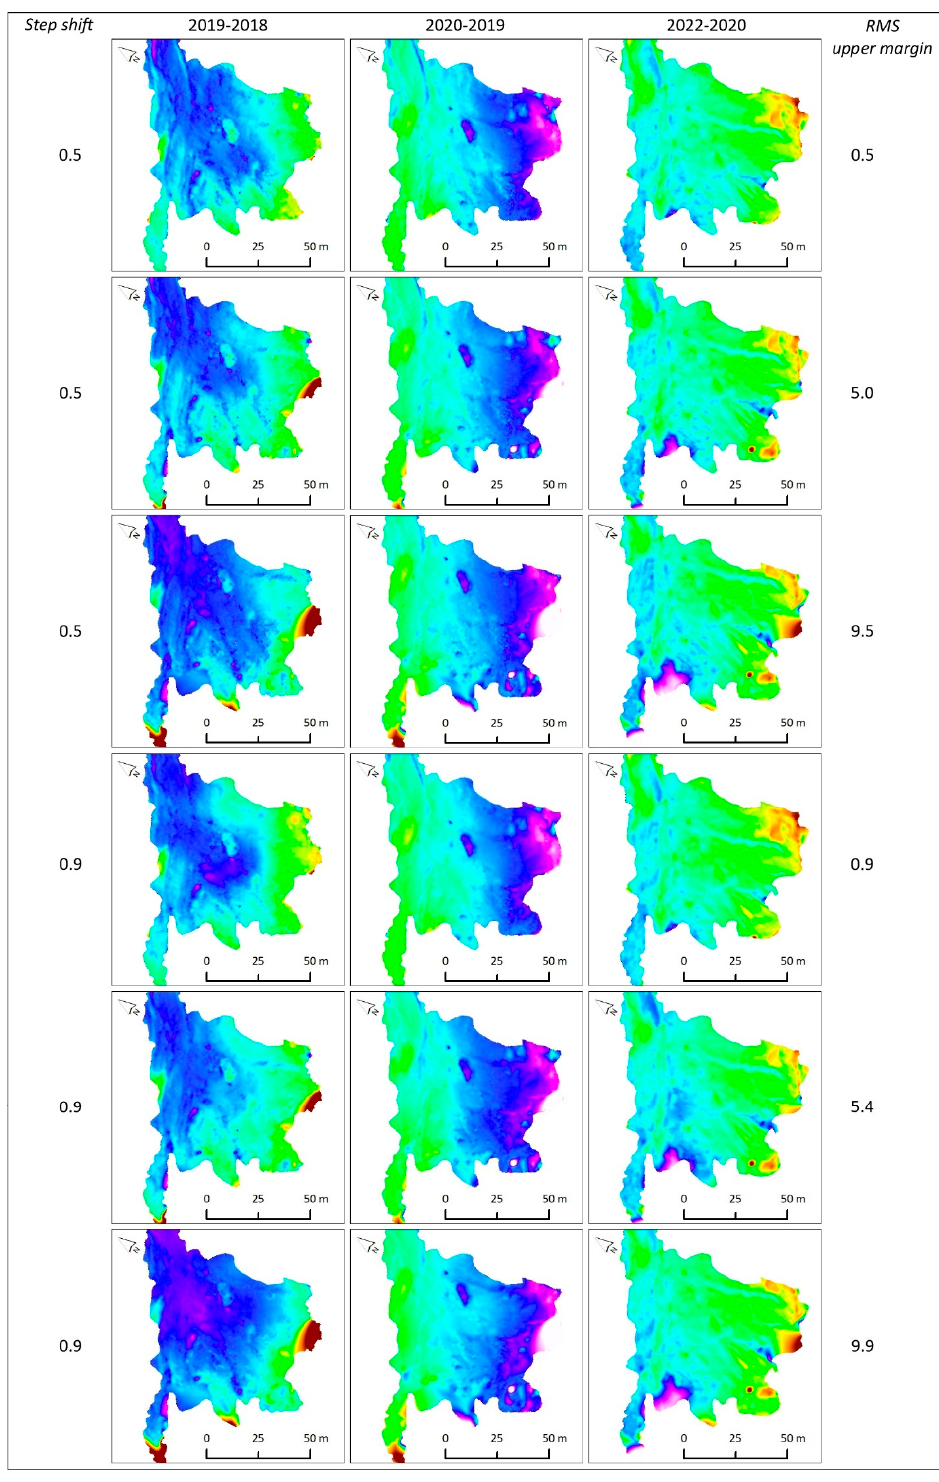
Figure 10. Simulated earthflow material displacements for each pair of flights. On the left-hand side, the size of the simulation step is presented; on the right-hand side, the upper value of the simulation interval is presented; on the middle part, the maps illustrate simulated earthflow material displacements; the simulation intervals are between the RMS upper margin minus step shift and RMS upper